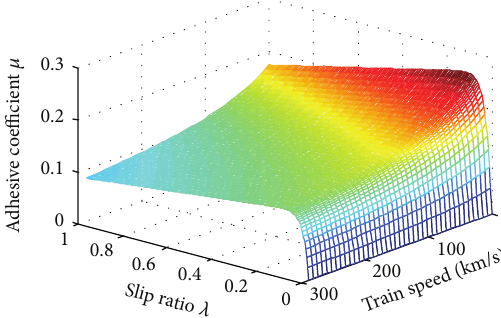
Figure 2: Adhesion force observer (